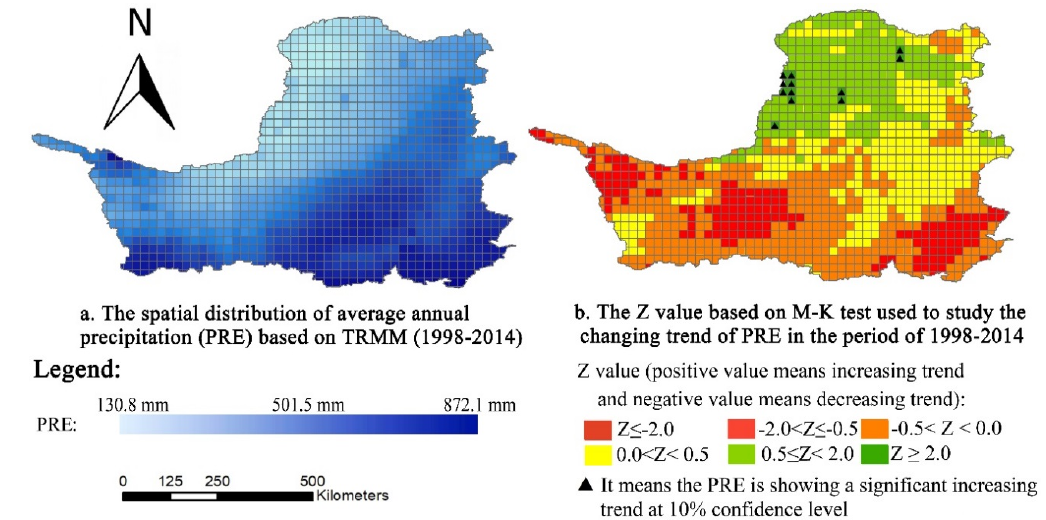
Figure 5. The spatial distribution of annual precipitation ( a ) and the changing trend in each grid of Loess Plateau ( b ).